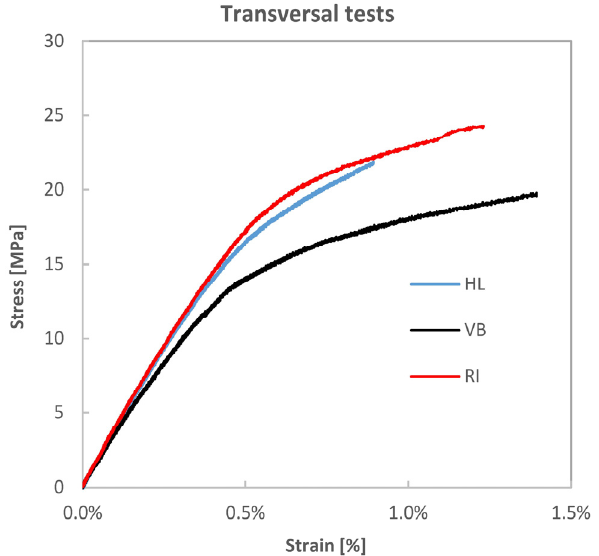
Figure 5. Transverse tensile stress vs. strain curves.